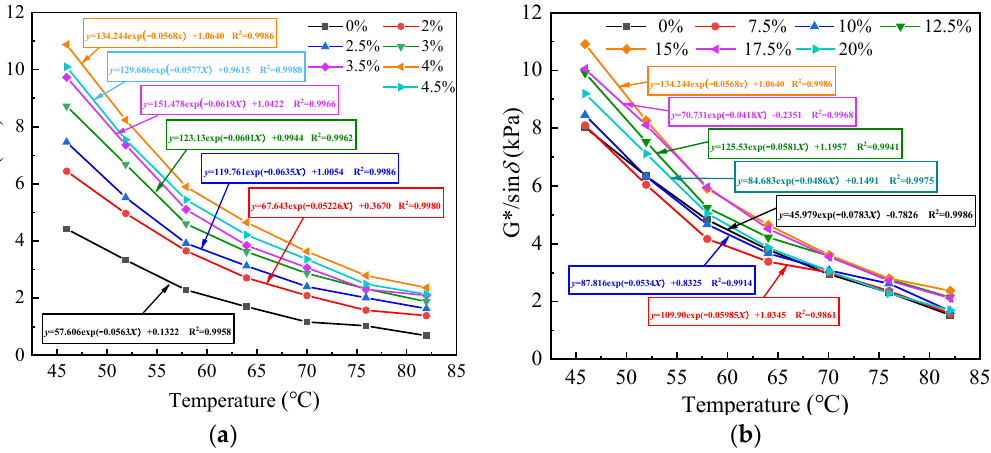
Figure 8. ( a ) The complex modulus of different content of RHB, ( b ) phase angle of different content of RHB.